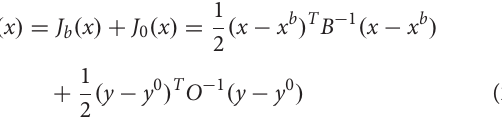
is, at the location where the lightning occurred, the relative humidity from the background at that column was adjusted to 90% if it was less than 90%. In particular, when the relative humidity was greater than or equal to 90% at that location, there was no adjustment. The CTH was determined using the CTH observations from FY4. The calculated LCL from the background fields was approximated as the cloud base height. The LCL was calculated using equation (1) (Sheng, 2003). Where T and TD are the temperature and dew point at a height of 2 m,